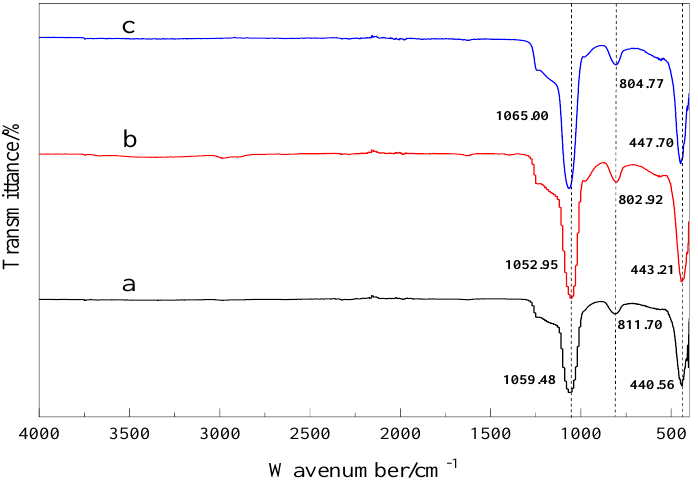
Figure 4. FTIR spectra for the samples. a —Mesoporous material synthesized with Gemini ionic liquid surfactant [N 1116 C 3 IMC 16 ][Br] 2 as template. b —Mesoporous material synthesized with Gemini ionic liquid surfactant [N 1116 C 3 N 1116 ][Br] 2 as template. c —Mesoporous material synthesized with Gemini ionic liquid surfactant [C 16 IMC 3 C 16 IM][Br] 2 as template.